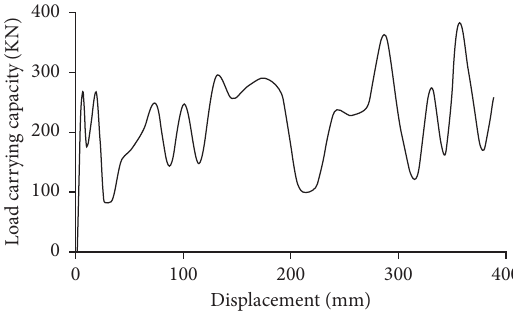
Figure 11: Bearing capacity changing curve of retractable O -shed stent under uniform impact